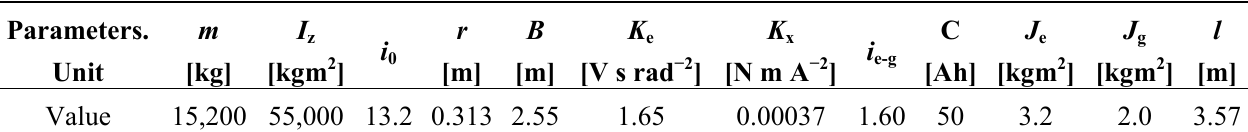
Table 1. Values of the vehicle’s key